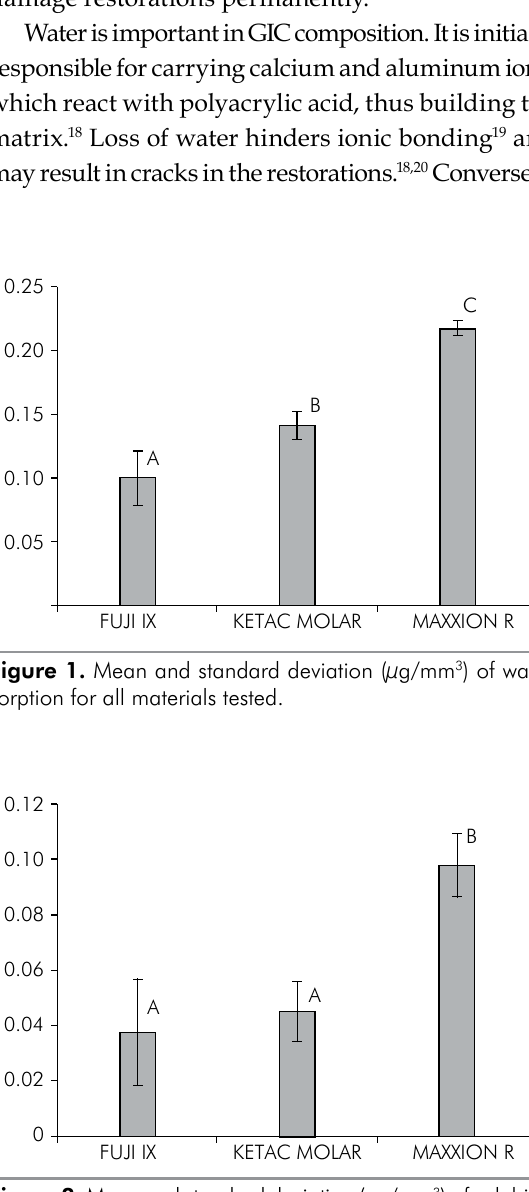
Figure 2. Mean and standard deviation (μg/mm 3 ) of solubility for all materials